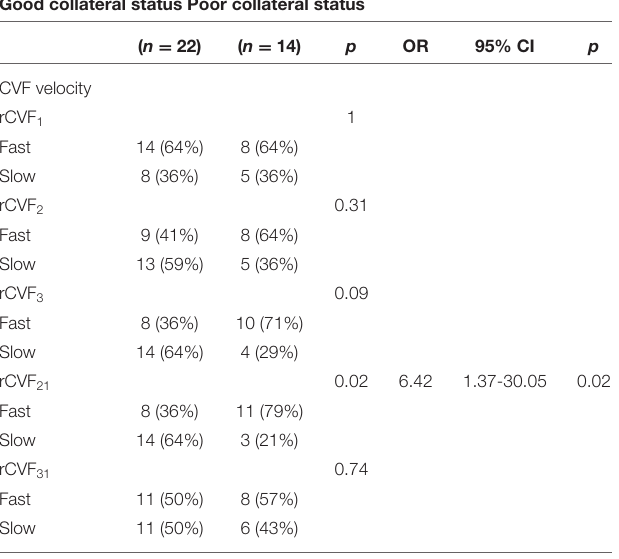
TABLE 4 | Relationship between CVF velocity and collateral status in symptomatic patients.